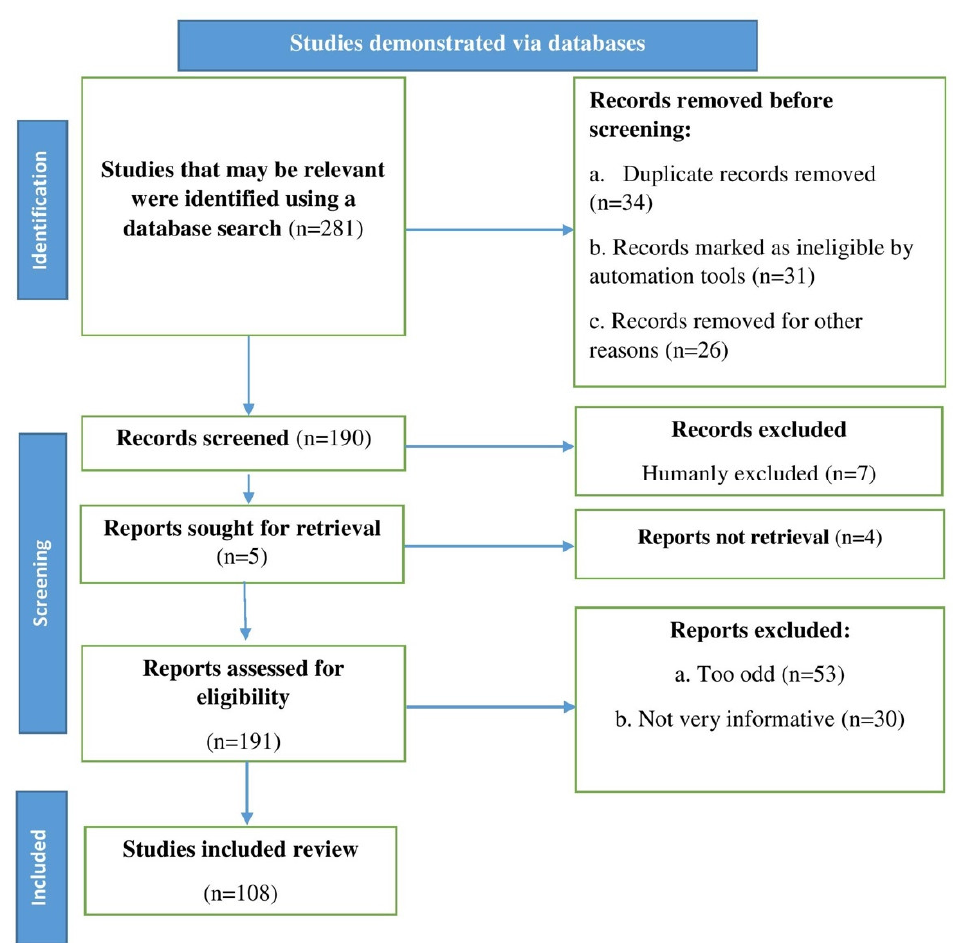
Figure 1. Stages involved in selecting published data for inclusion in this study are depicted in a flow chart. Key: n, number of literatures. chart. Key: n, number of